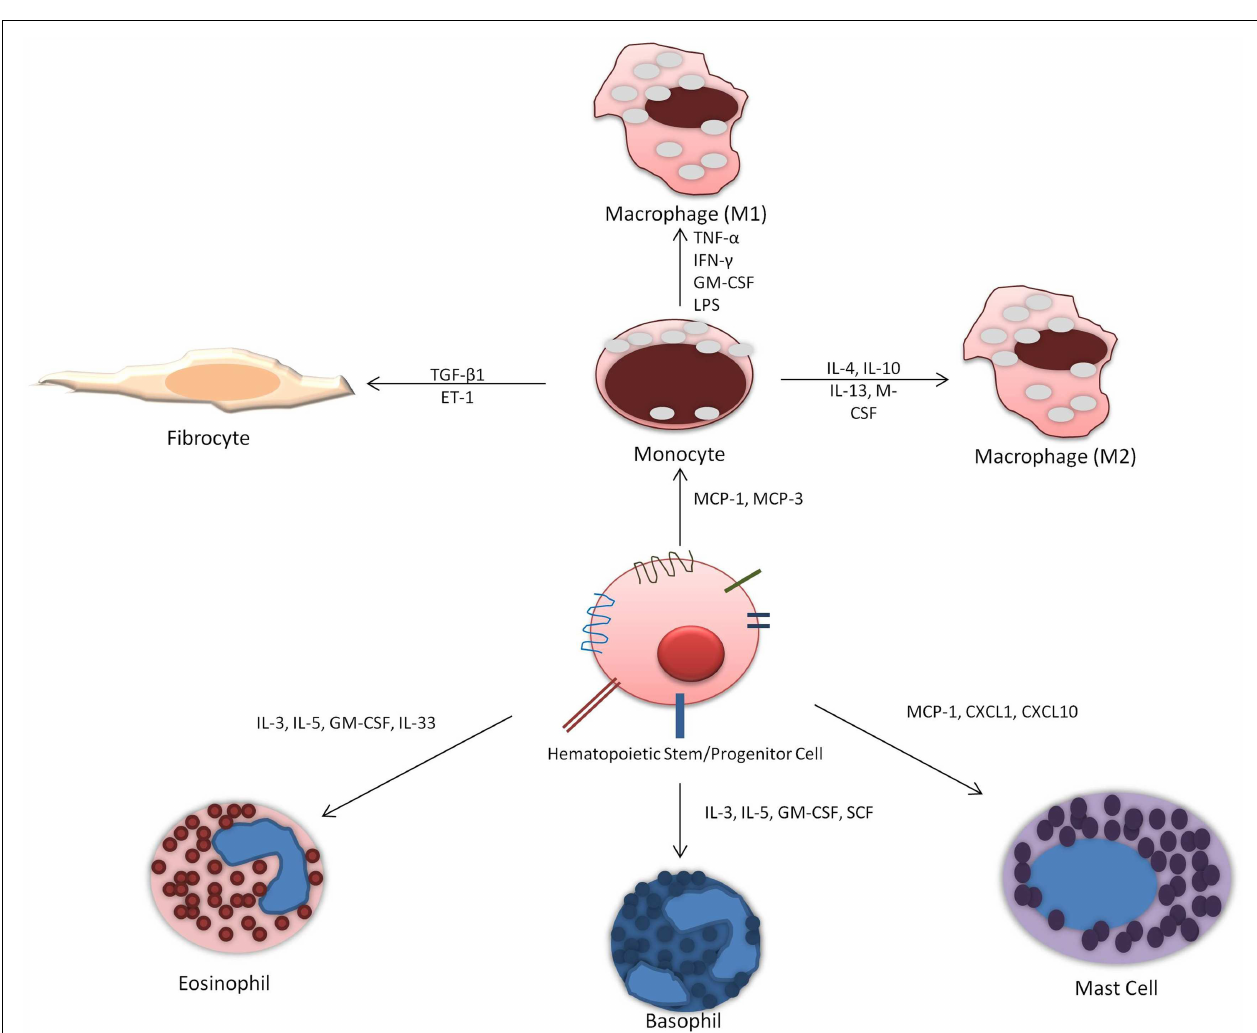
FIGURE 2 | Differentiation of hematopoietic progenitor cells into immune cells: HSPCs can potentially differentiate into distinct immune cells in situ depending on the presence of locally elevated factors and cytokines .